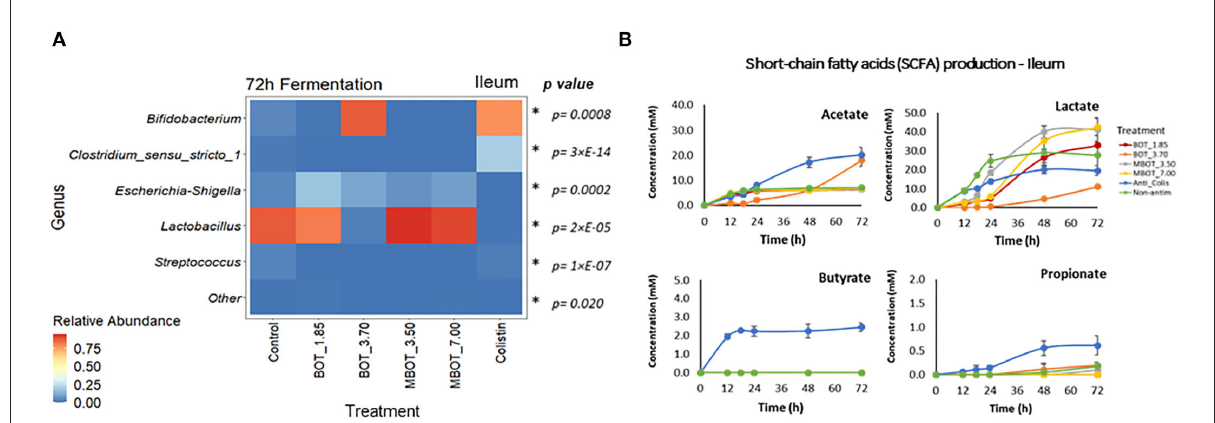
FIGURE4 Heat map of the relative abundance of the top-5 genera present in ileum microbial fermentation (A) and short chain fatty acid (SCFA) production (B) as affected by unprotected BOT, microencapsulated BOT (MBOT), and colistin after 72h of fermentation. p -values were calculated by a one-way ANOVA model and asterisks (*) indicate significant differences ( p < 0.05). Vertical bars indicate the standard deviation.